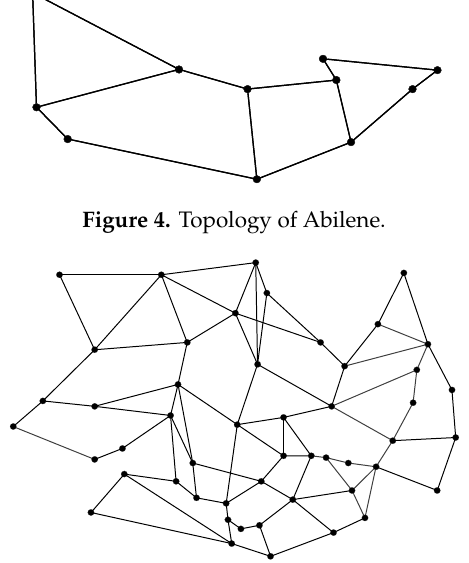
Figure 5. Network Topology of Germany50 .